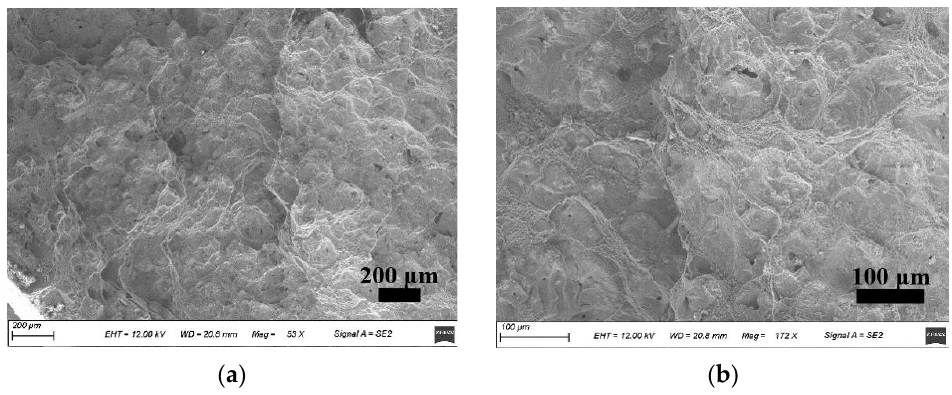
Figure 11. Creep fracture of the ‘micro’ specimen. ( a ) Low-magnification creep fracture and ( b ) High- magnification creep